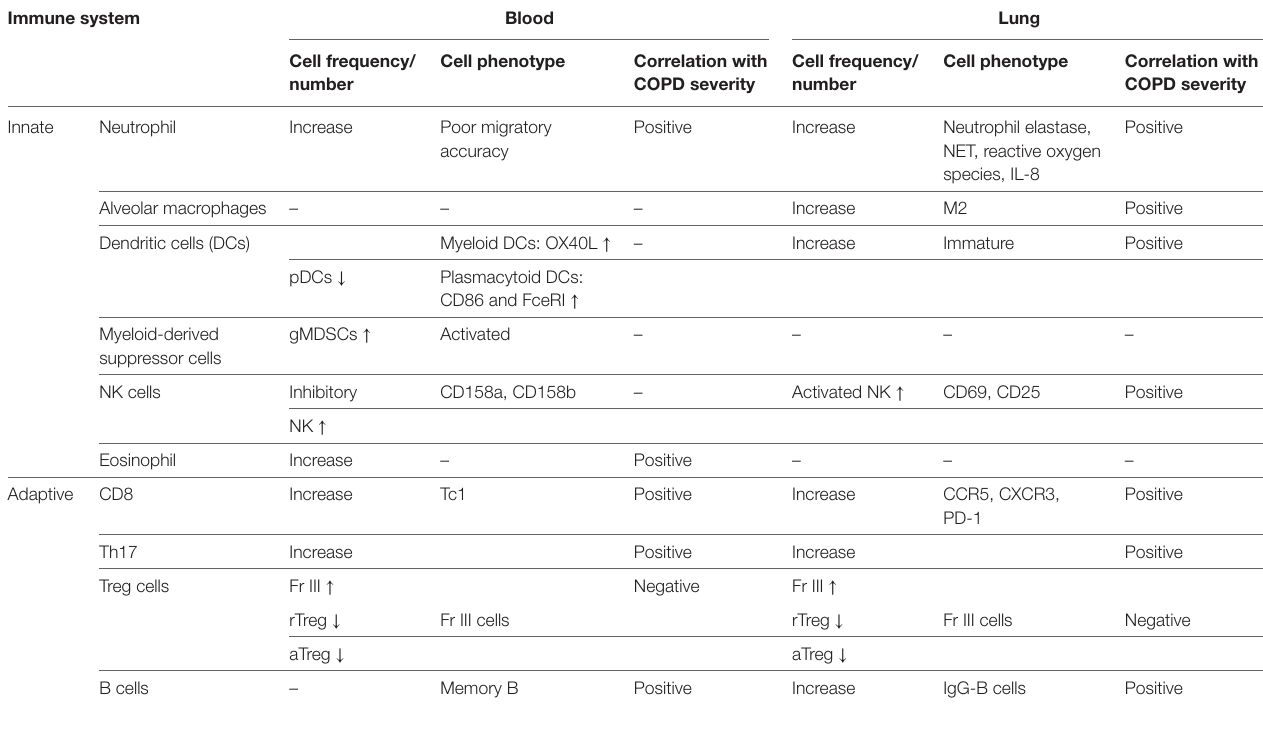
TAbLe 1 | Immune cells and chronic obstructive pulmonary disease